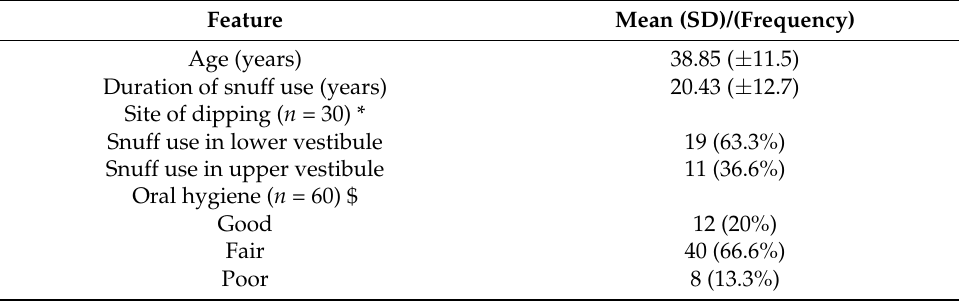
Table 1. General characteristic of the study groups.